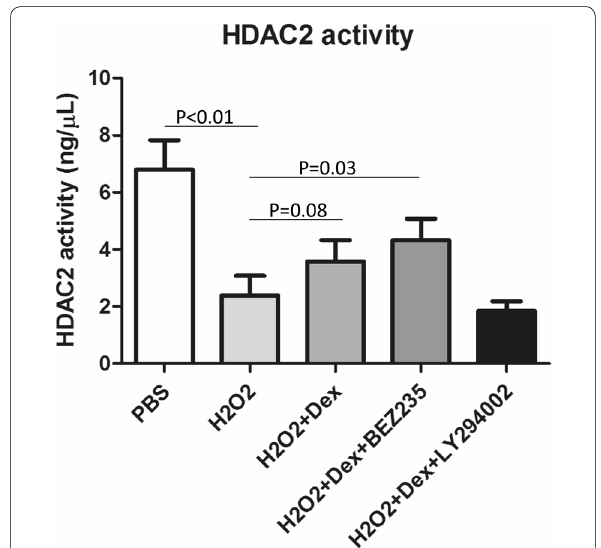
Fig. 6 Dexamethasone alone and in combination with BEZ235 partially reversed HDAC2 activity in the H 2 O 2 -U937 cell model. The HDAC2 activity assay results showed that H 2 O 2 markedly reduced HDAC2 activity. Dexamethasone alone or in combination with a PI3K inhibitor (BEZ235) partially reversed HDAC2 activity, especially in the combination treatment group (p < 0.05: statistically significant. Each experiment was repeated at least three